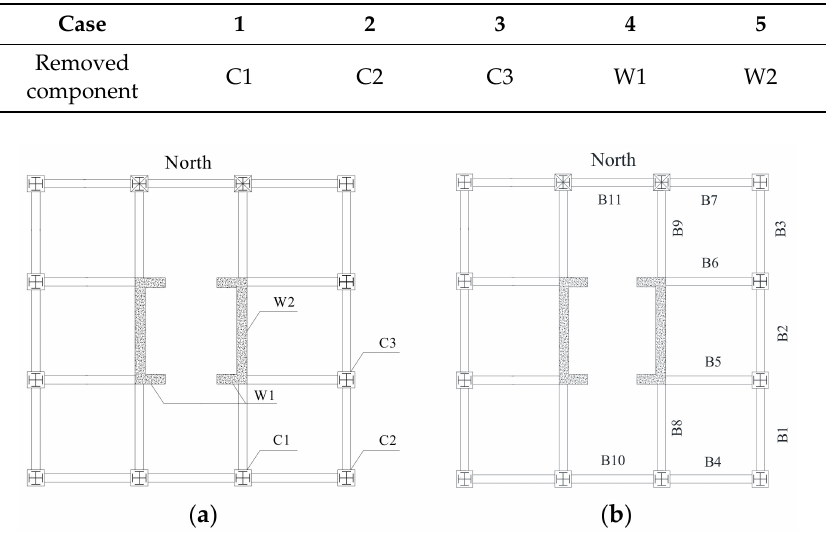
Figure 14. Location of members at the first floor: ( a ) location of key components and ( b ) location of the adjacent